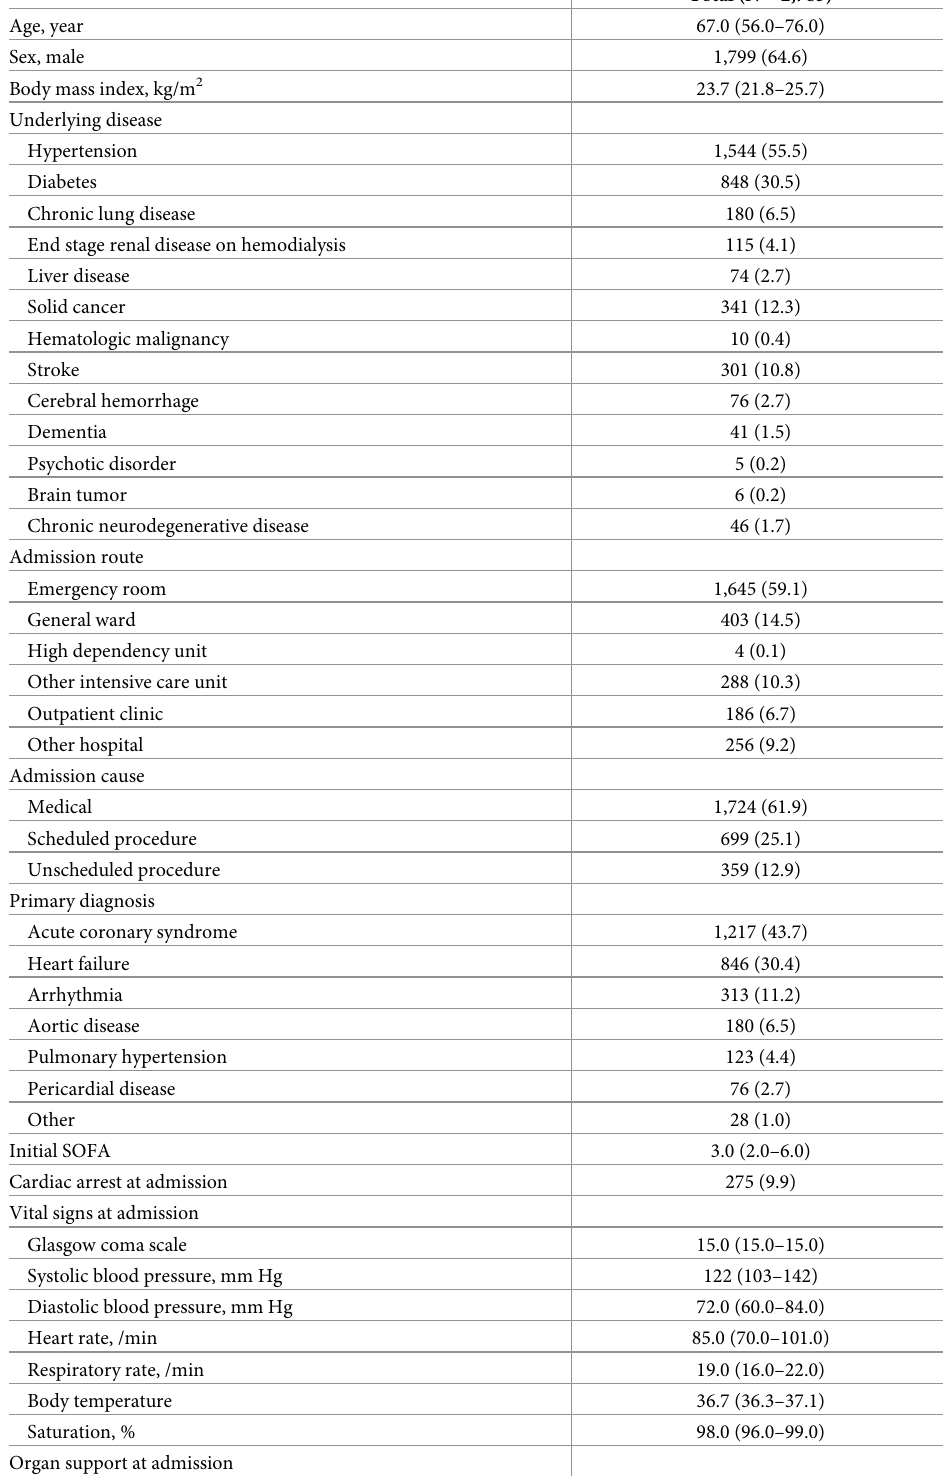
Table 1. Clinical characteristics of the study